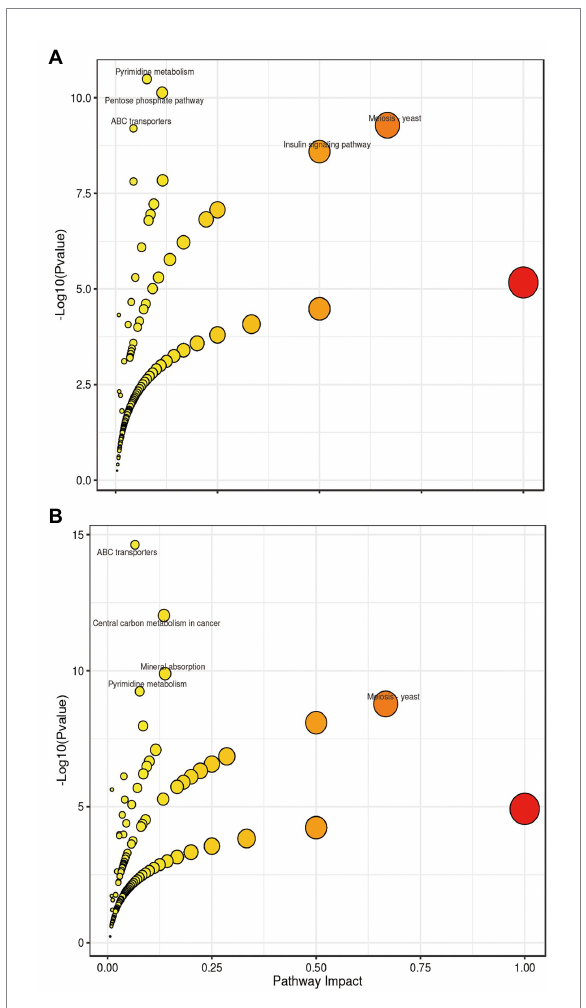
FIGURE 4 Bubble chart of the metabolic pathways in which the differential metabolites identified after fermentation participate. (A) Lactobacillus plantarum R9. (B) Lactobacillus gasseri B1-27. Each bubble represents a metabolic pathway. The impact value of each enriched pathway is displayed in the X-axis and the − log 10 (P) value in the Y-axis. The smaller the p value, the more significant the impact of the detected differential metabolites on the pathway is. The larger the impact value, the larger the dot, which means the higher the contribution of the metabolites detected on that pathway, and the greater the impact on the metabolic pathway. Colors are related to p values; the lighter the color, the larger the p